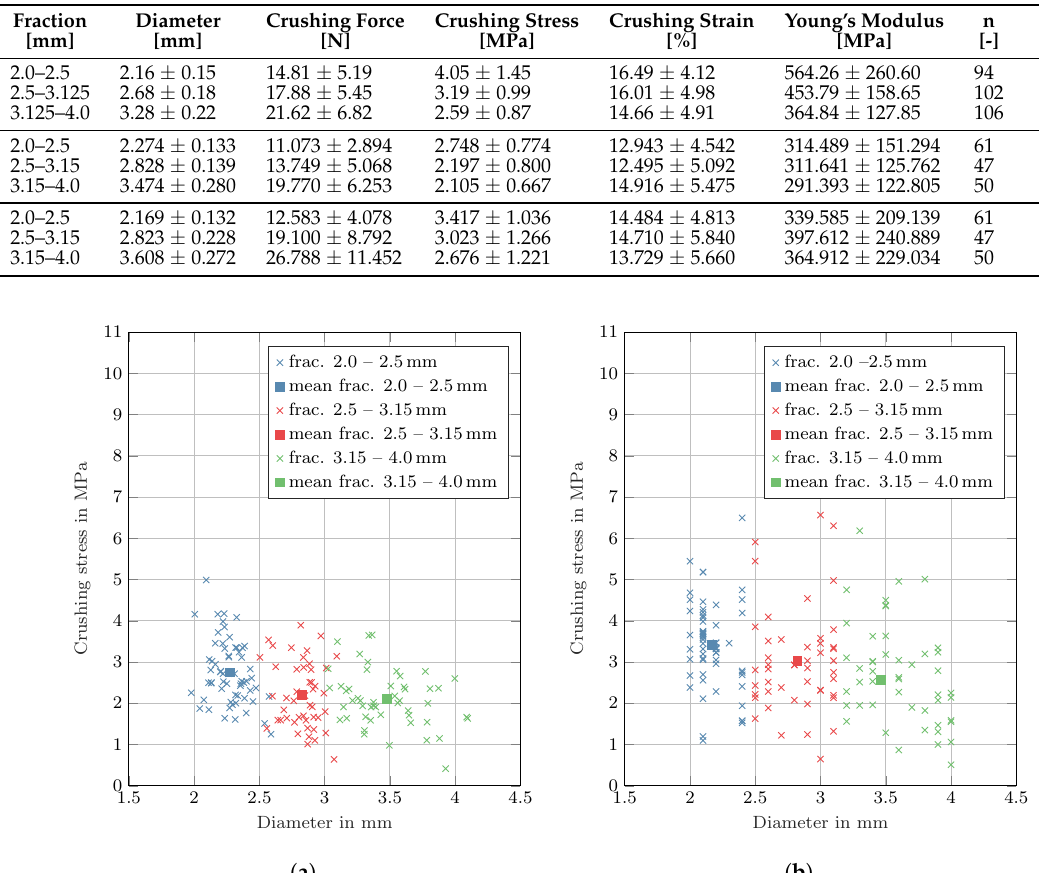
Figure 7. Distribution of crushing stress from single particles compression test of Candellila wax- coated and silicone-coated Poraver ® particles from all diameter fractions. ( a ) Poraver ® —Candelilla wax. ( b ) Poraver ®